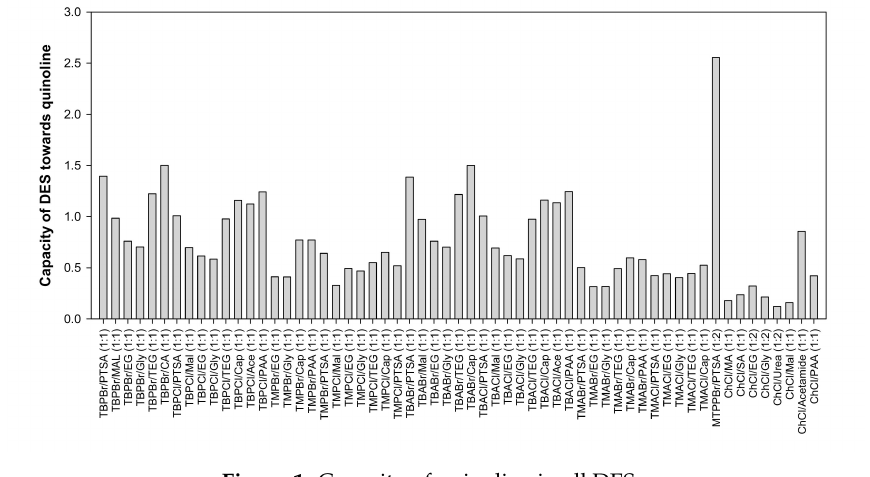
Figure 1. Capacity of quinoline in all DESs.